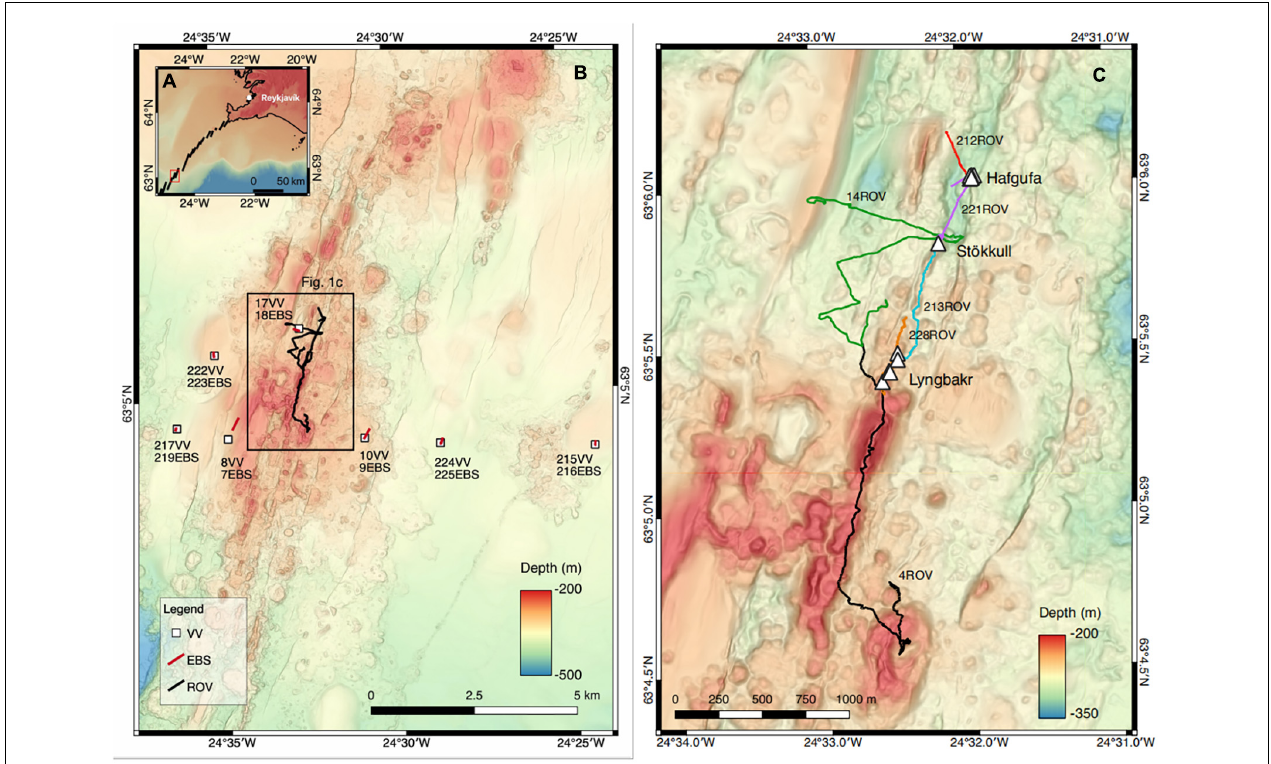
FIGURE 1 | (A) Regional map showing the northern section of the Reykjanes Ridge, indicated by a black line. The red box show the extent of the study area (B) . (B) Map of Steinahóll axial volcanic ridge at 5 m resolution with ROV tracks shown in black. The different sampling stations are located and named. Epibenthic sled (EBS) track are shown by a red line, ROV dive track by a black line, and Van Veen grab (vV) position is indicated by white squares. The black box shows the extent of (C) . (C) Map of the Steinahóll vent sites. Hydrothermal vents (white triangles) are grouped in three hydrothermal field named Hafgufa, Stökull, and Lyngbakr. Venting is indicated by white triangles. ROV dives are individualized by different color